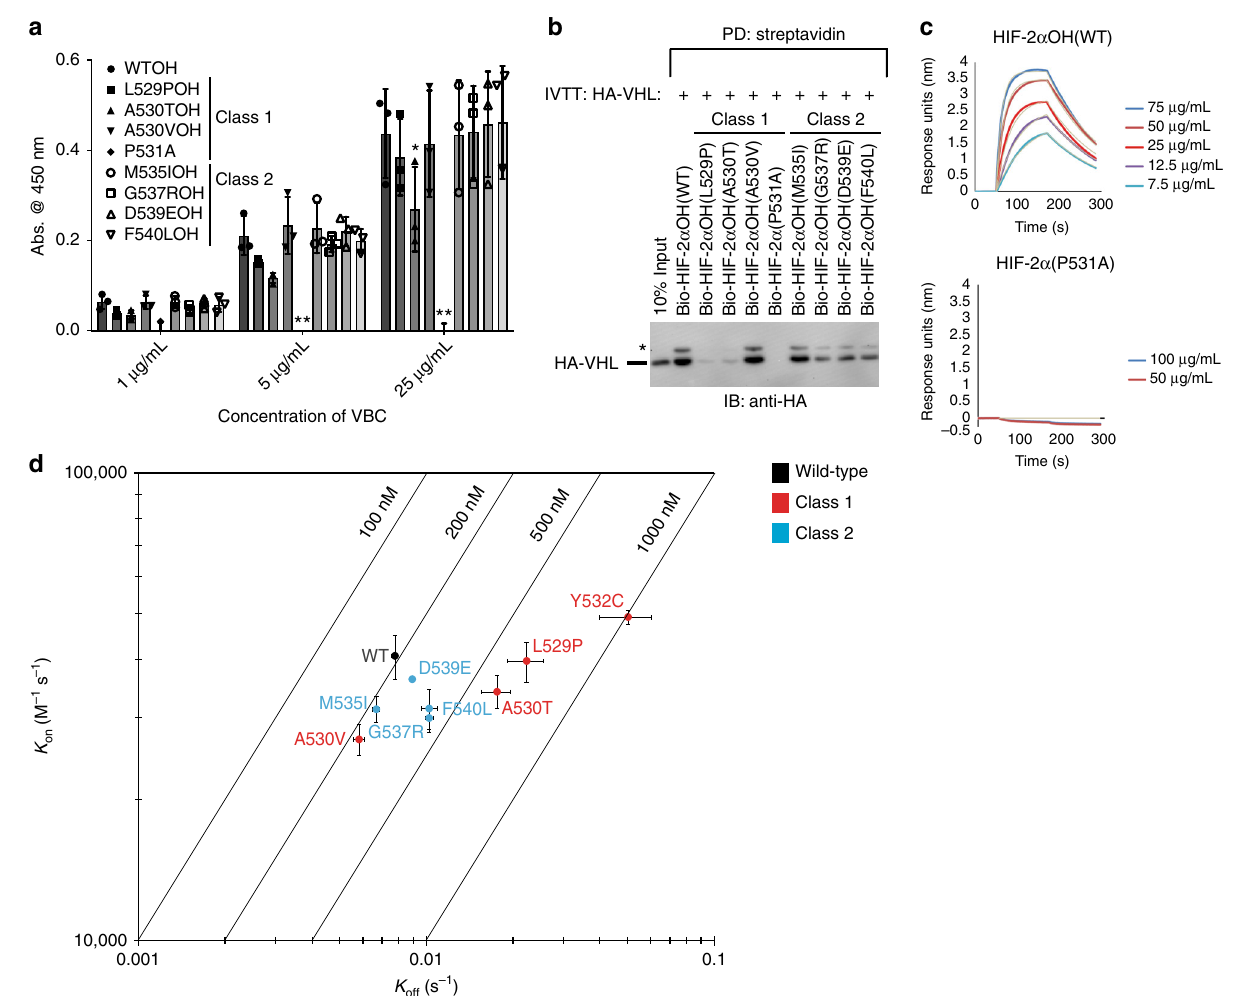
Fig. 4 Af fi nity of HIF-2 α mutants for pVHL is correlated with disease phenotype. a Biotinylated HIF-2 α peptides (523 – 541) were immobilized on a streptavidin-coated 96-well plate. Binding to various concentrations of pVHL-elongin B-elongin C (VBC) complex was assayed via ELISA with an anti-eloB antibody. Absorbance was read at 450 nm. Values represent mean of three independent experiments performed in duplicate ± SEM. * p < 0.05; ** p < 0.01. b Biotinylated HIF-2 α OH peptides (523 – 541) were immobilized on streptavidin- agarose beads and incubated with in vitro transcribed and translated (IVTT) pVHL. Streptavidin beads were pulled down (PD) and levels of HA-tagged pVHL were visualized via immmunoblotting (IB). c , d Biolayer interferometry kinetic analysis of VBC complex binding to biotinylated HIF-2 α peptides (523 – 541). c Biotinylated peptides were coupled to streptavidin- coated biosensors and monitored for binding to VBC complex at the indicated concentrations. The data were analyzed based on a 1:1 binding model using the BLItz Pro software with the fi tted curves shown as gray lines. Sensorgrams are representative of three experiments conducted with independently puri fi ed protein. d Rate plane with Isoaf fi nity Diagonals (RaPID) plot highlighting the kinetic parameters of VBC complex binding to HIF-2 α peptides. Values represent mean of three experiments conducted with independently puri fi ed protein ± SEM. * denotes uncharacterized